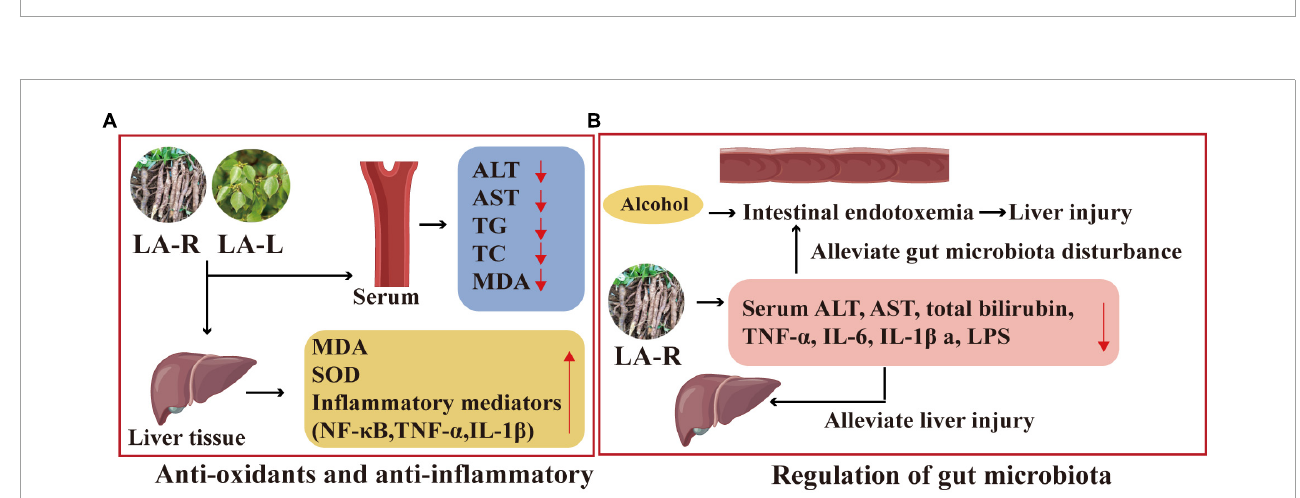
FIGURE9 Liver protection mechanism of action of L. aggregata . (A) Anti-oxidants and anti-inflammatory. (B) Regulation of gut